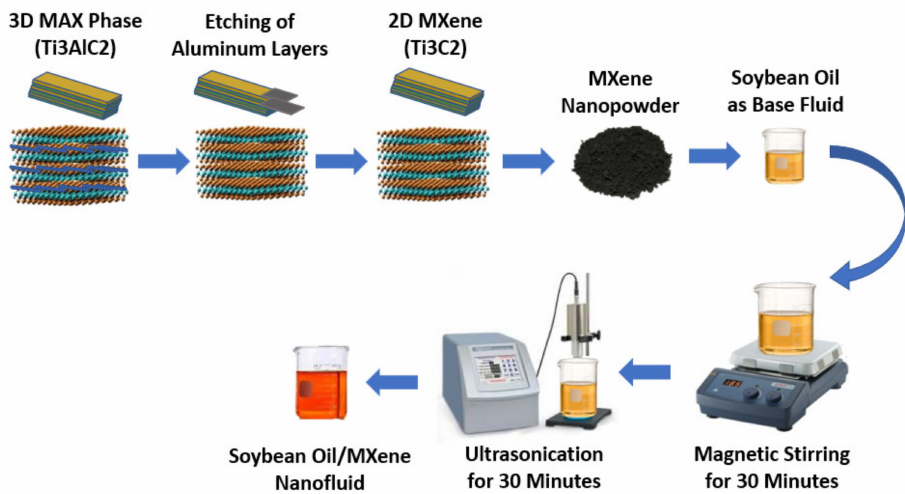
Figure 10. Main steps of the preparation of the MXene/soybean oil 2D nanofluid. Adapted from